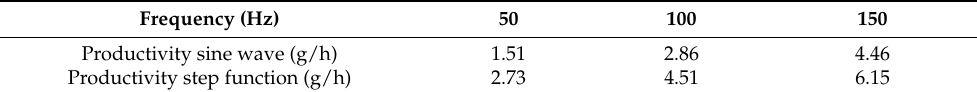
Table 2. Productivity change of the PA 6 solution with H 2 SO 4 when exposed to various step change signal frequencies.